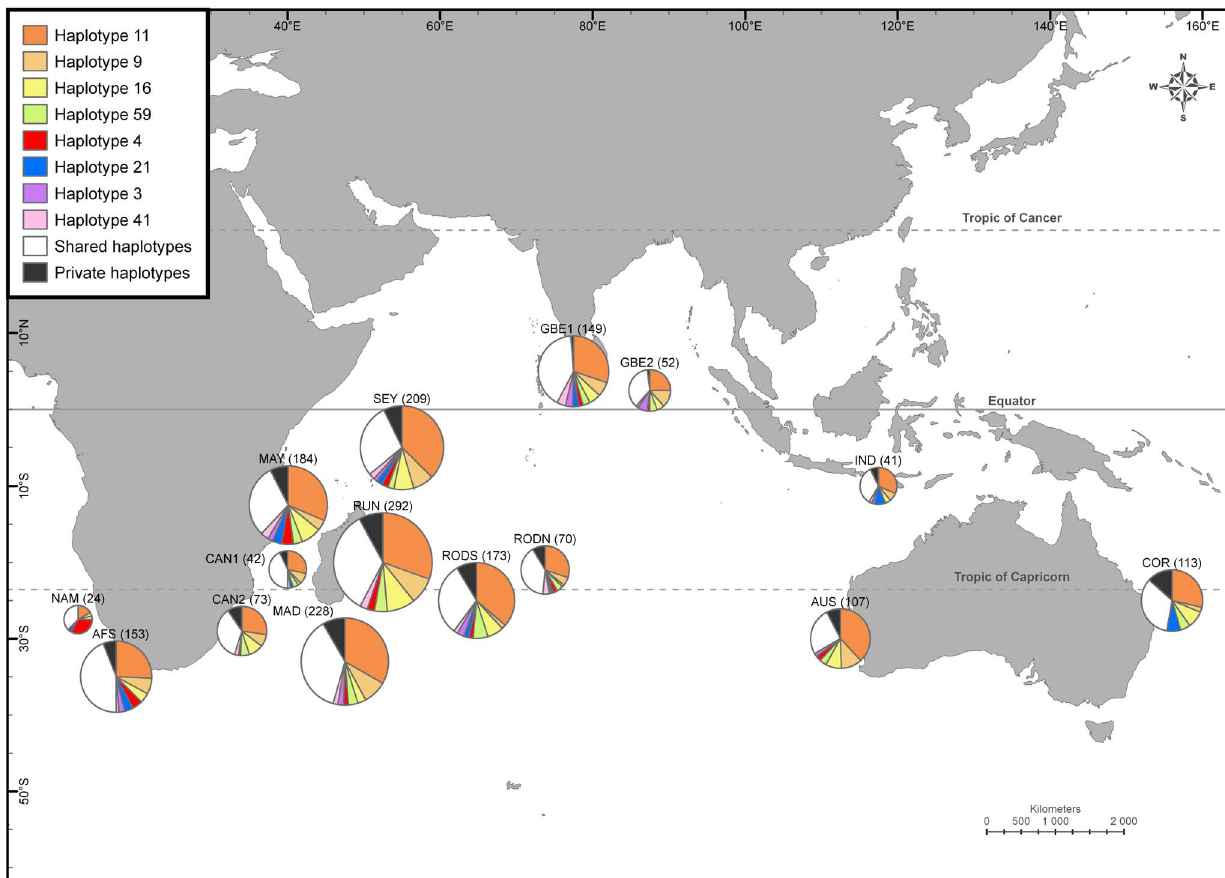
Figure 3. Map of plotted frequencies of the main ND2 haplotypes, shared haplotype and private haplotypes per identified areas. Number of samples is shown in brackets.